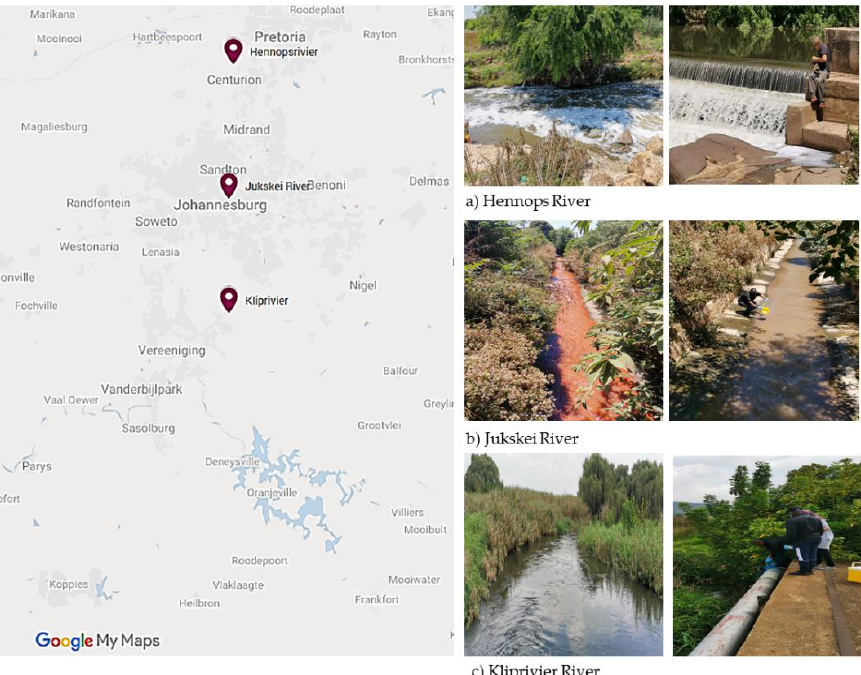
Figure 1. Map of the water sampling sites for study areas within the Johannesburg region. Shown are the locations ’ approximate sampling points of the ( a ) Hennops, ( b ) Jukskei and ( c ) Kliprivier Rivers investigated in this